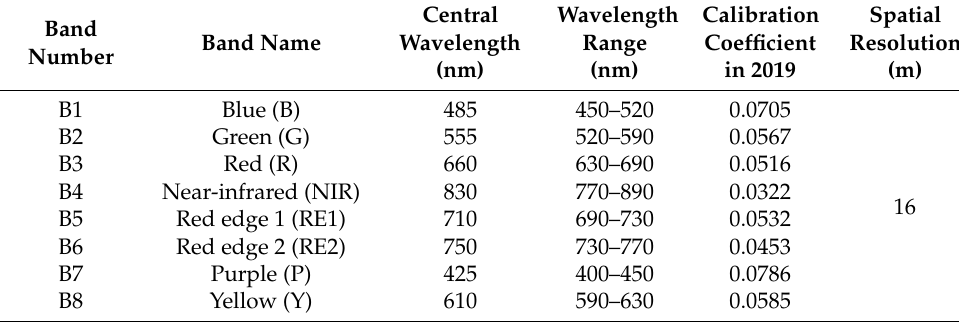
Table 1. Main information parameters of GF-6 WFV data.